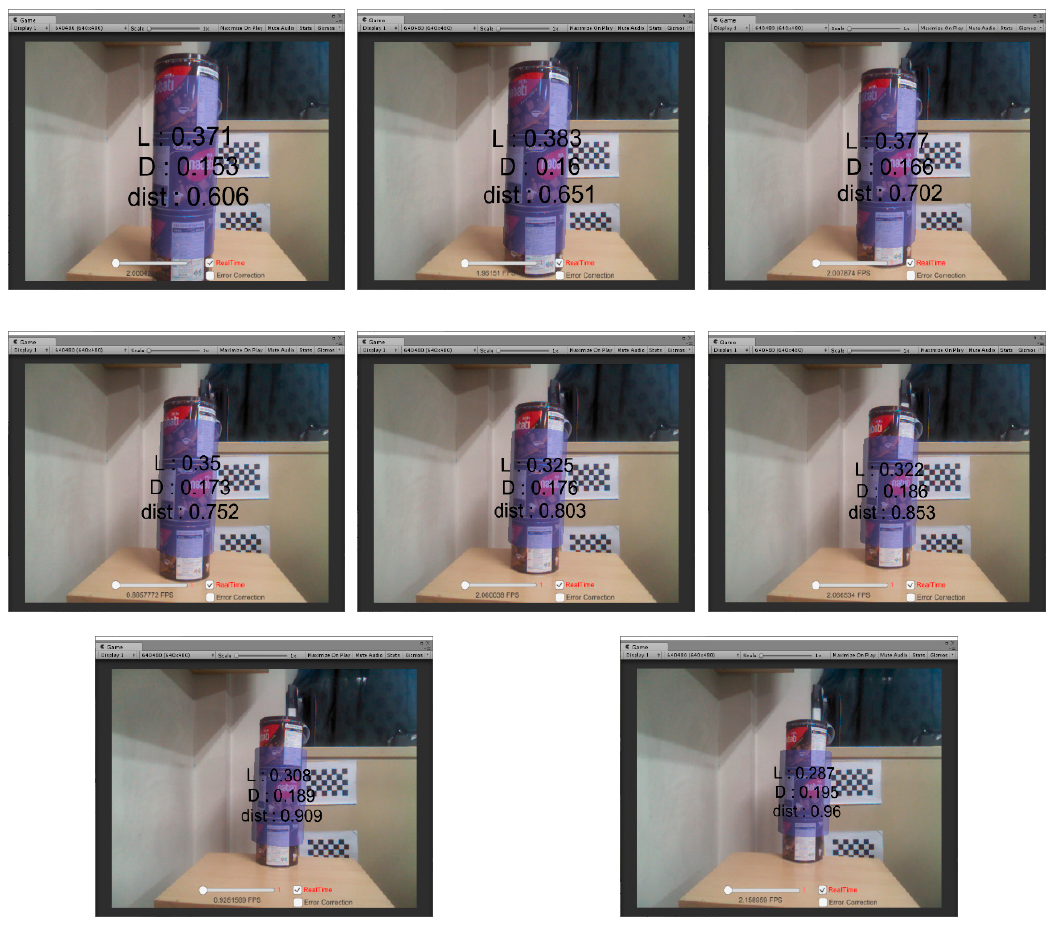
Figure 14. Errors due to distance (m).